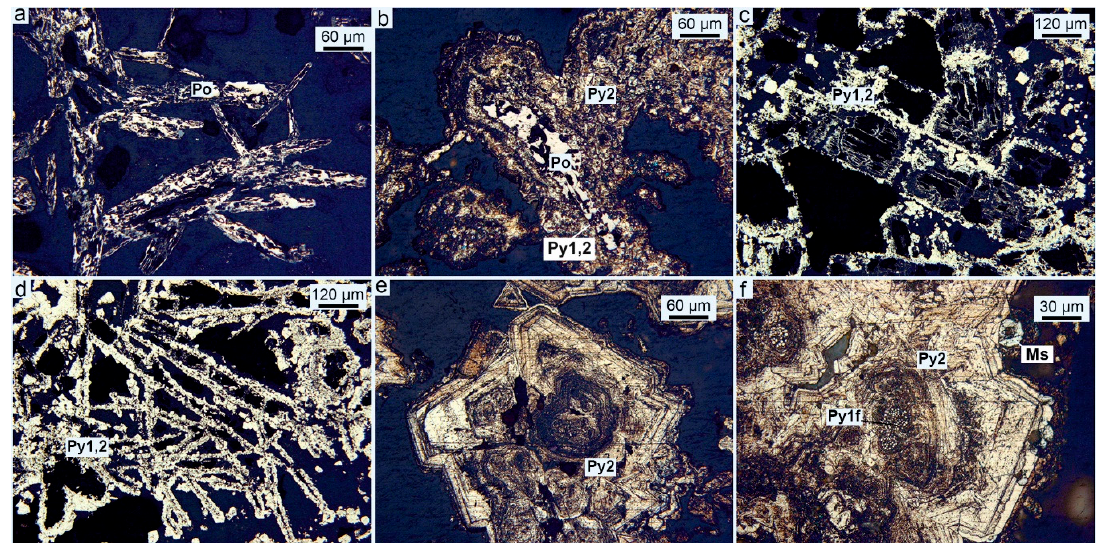
Figure 7. Varieties of pyrite in pyrite microfacies-195. Pobeda-1 hydrothermal field. ( a ) subhedral elongate pyrrhotite (Po) crystal framework; ( b ) relic inclusion of pyrrhotite (Po) is overgrown by subhedral pyrite-2 (Py2) (37L-195-2); ( c ) box-like pseudomorphs of pyrite (Py1,2) after pyrrhotite crystals ( d ) network microtexture of pyrite aggregates (Py1,2) formed after friable pyrrhotite masses; ( e ) oscillatory coarse-zoned pyrite-2s (Py2) envelops relic colloform pyrite (37L-195-2); ( f ) relict inclusions of framboidal pyrite (Py1f) in coarse-zoned pyrite-2 (Py2) (37L195-3). Reflected light. Some pyrite varieties (b,e,f) were etched by HNO 3 + CaF 2 .